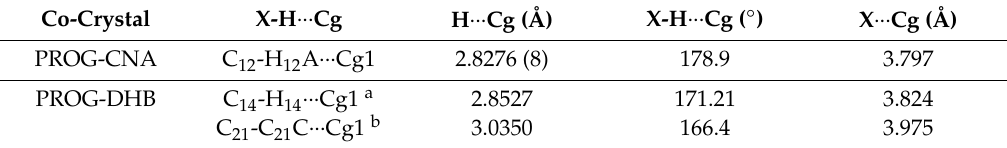
Table 1. C-H ··· π intermolecular interactions in PROG-CNA and PROG-DHB. Co-Crystal